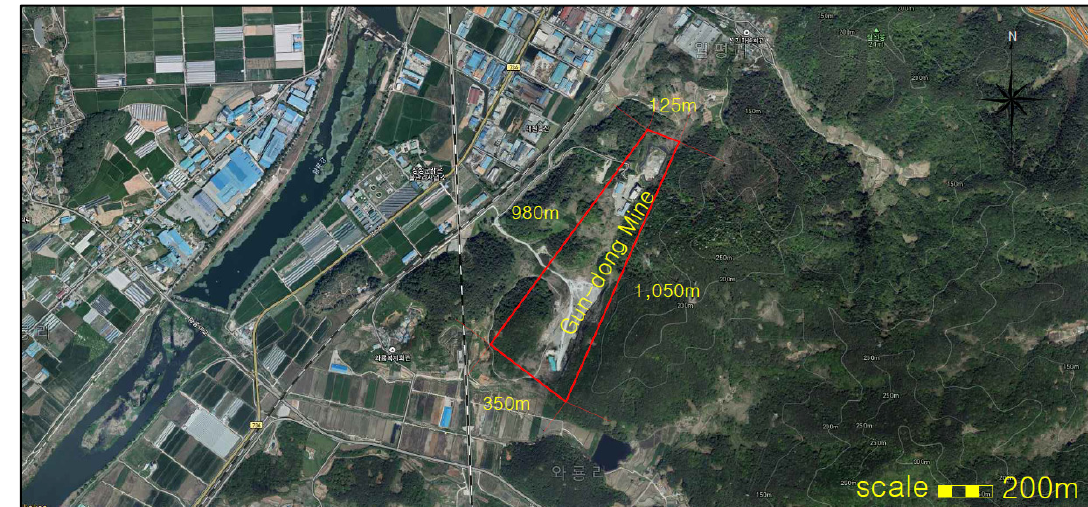
Figure 2. Aerial view of Gun-dong mine and adjacent areas.